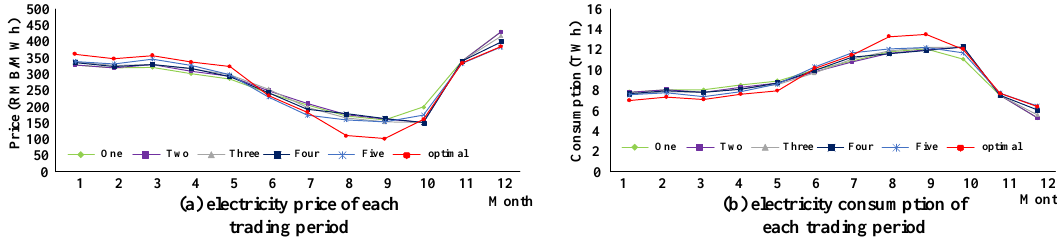
Figure 10. The monthly electricity consumption and market clearing price under different regulation scenarios: ( a ) electricity price of each trading period; ( b ) electricity consumption of each trading period.